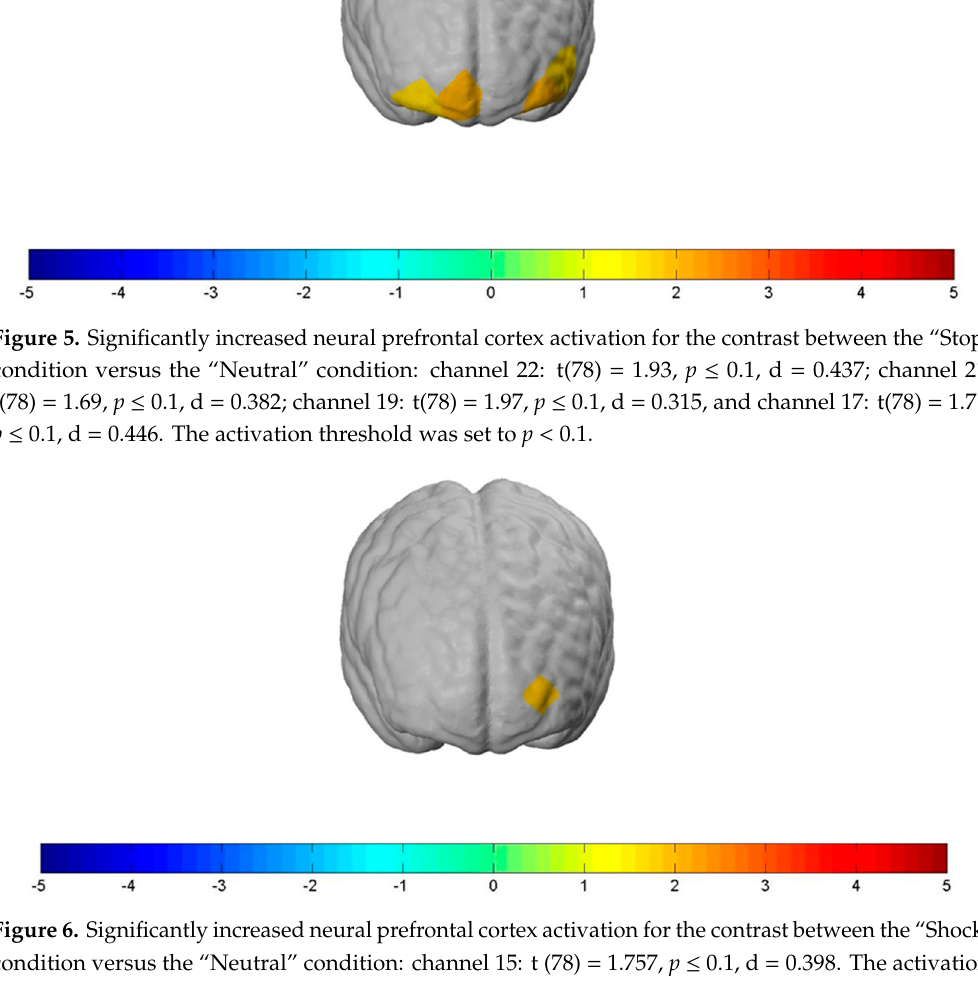
Figure 6. Significantly increased neural prefrontal cortex activation for the contrast between the “Shock” condition versus the “Neutral” condition: channel 15: t (78) = 1.757, p ≤ 0.1, d = 0.398. The activation threshold was set to p < 0.1.